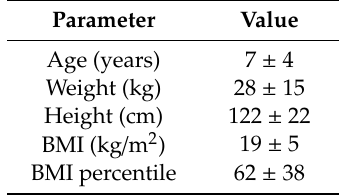
Table 1. Anthropometric data for the whole study sample.